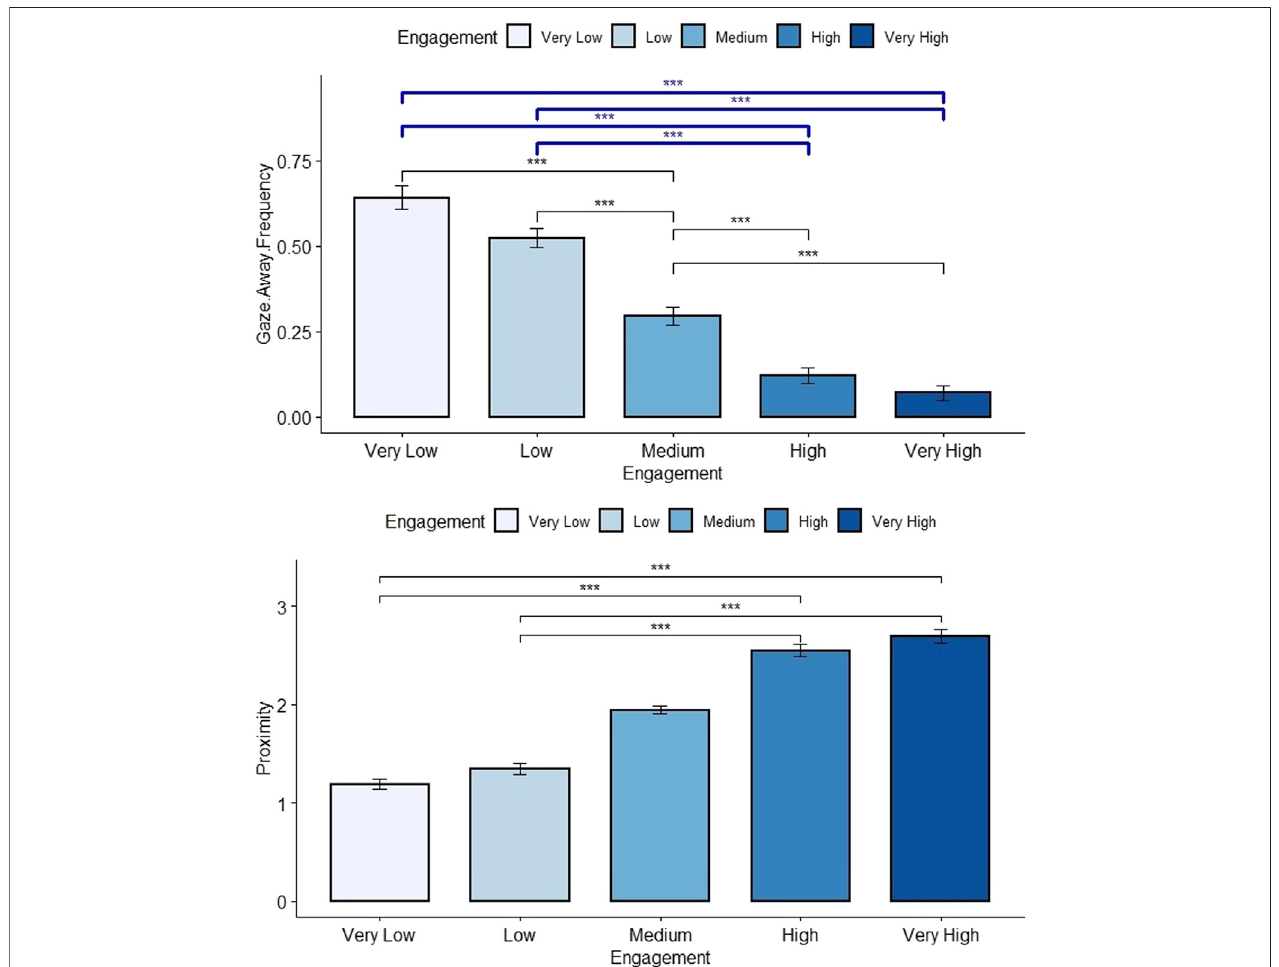
FIGURE 5 | Distribution plot of the gaze away frequency and the posture proximity depending on the engagement (Arousal) levels. Signi fi cant results with the Medium Engagement level was removed for clarity purpose. Main signi fi cant results from the pairwise tests related to the gaze are shown in blue above the bar charts, Table 2 for details.